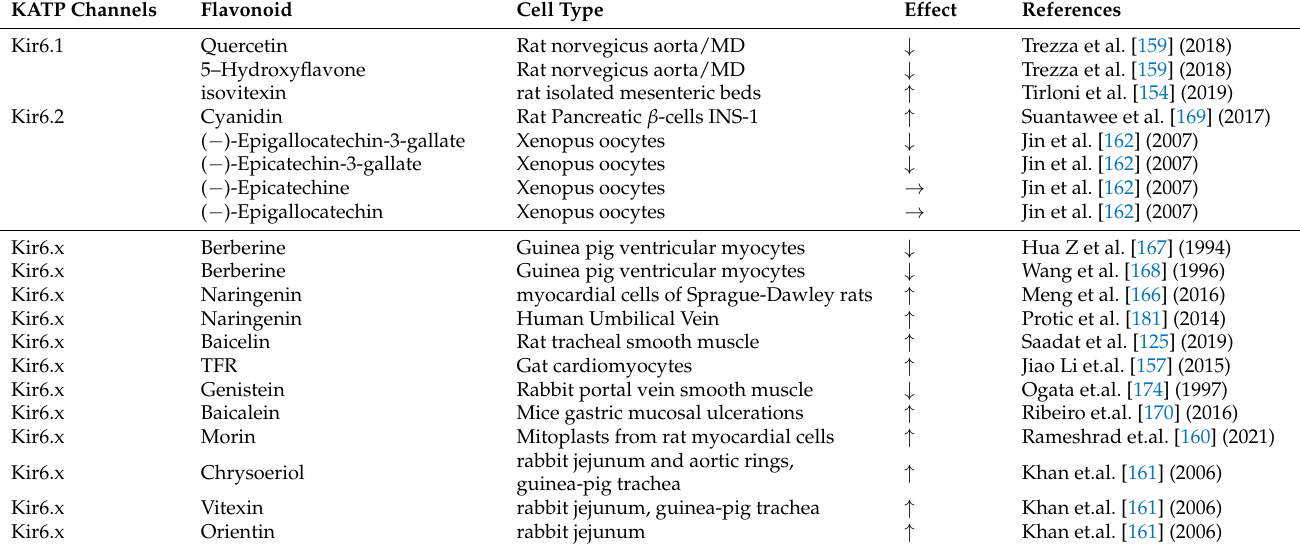
Table 4. The effects of flavonoids on the KATP channels. The ↑ represents channel activation and ↓ denotes channel inhibition, while → stands for no effect on channel